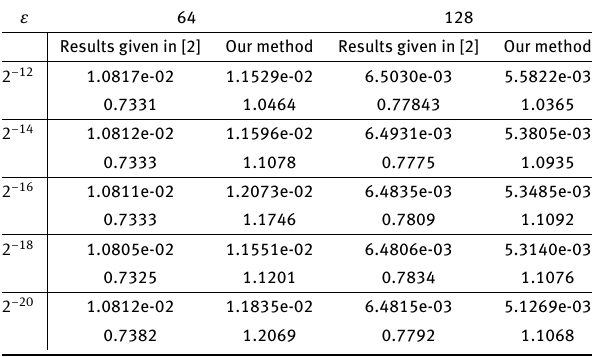
Table 2: Comparison of the numerical results ε 64